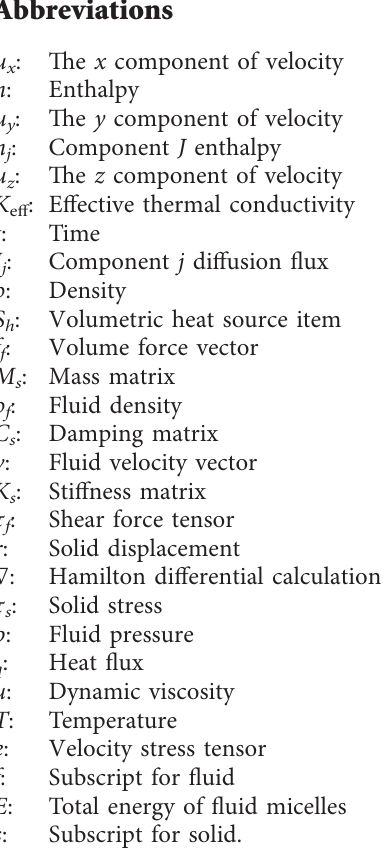
Figure 26: Single thermowell.